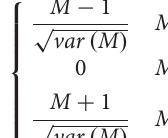
When S FVC > 0, the FVC of the time series shows an increasing trend; when S FVC < 0, the FVC of the time series shows a decreasing